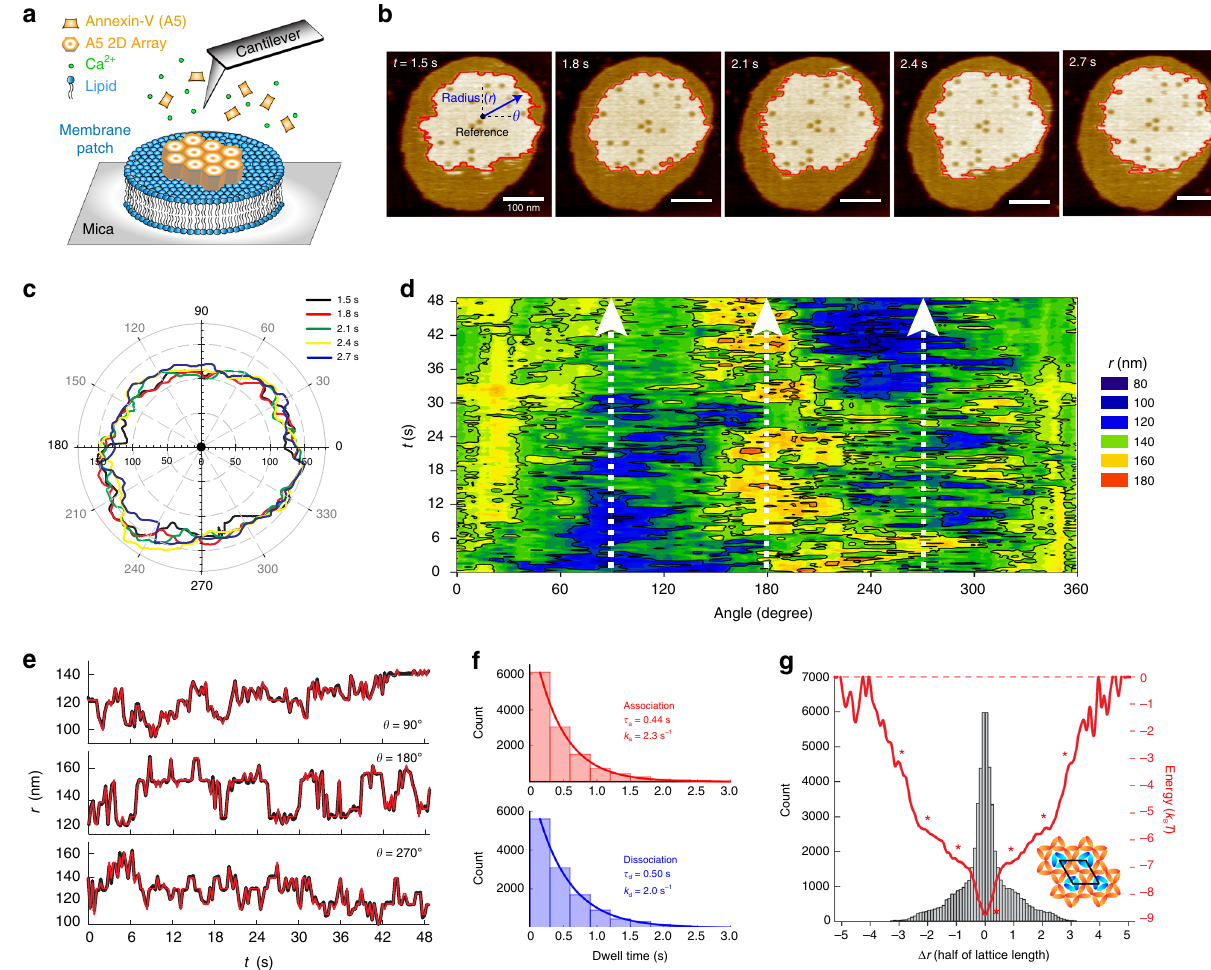
Fig. 2 A5 association and dissociation kinetics to and from a 2D-lattice. a Schematic of the experimental setup. Membrane patches (DOPC/DOPS 50:50) are deposited on a mica sample support. The fl uid cell contains HEPES buffer (pH 7.4) supplemented with 2 mM Ca 2 + . After addition of A5 to the fl uid cell, HS-AFM observes the formation of A5 2D-lattices on membrane patches. b HS-AFM image frames (Supplementary Movie 1) showing that the borders of fi nite A5-lattices are dynamic. HS-AFM movie acquisition speed: 0.3 s per frame. c Time-lapse series (lines of different colors) of 2D-lattice boarder in polar coordinates. The reference point is the center of mass of the A5 lattice in the fi rst panel of b . d Angle( θ ) – time( t ) map of A5 2D-lattice border radius ( r ). The false color scale represents varying radius from the lattice center to the edge. e Kymographs of A5 2D-lattice leading-edge radius at speci fi c angle (white dashed lines in d ). The red curves represent the idealized traces used for dwell-time analysis. f Dwell-time analysis of the association and dissociation kinetics at the leading edges of the A5 2D-lattice. g Histogram of the leading-edge radius change. The x -axis is scaled to half of the lattice unit cell length, 8.85 nm, corresponding to the lattice extension/decrease through association/dissociation of one A5 trimer. Each p6 unit cell contains two lattice A5 trimers. The relative energy diagram of A5 2D-lattice association and dissociation (red line) is estimated by N / N 0 = exp( Δ G / k B T ), where N 0 is the occurred events for Δ r = 0. The zero-energy level is de fi ned at the positions without